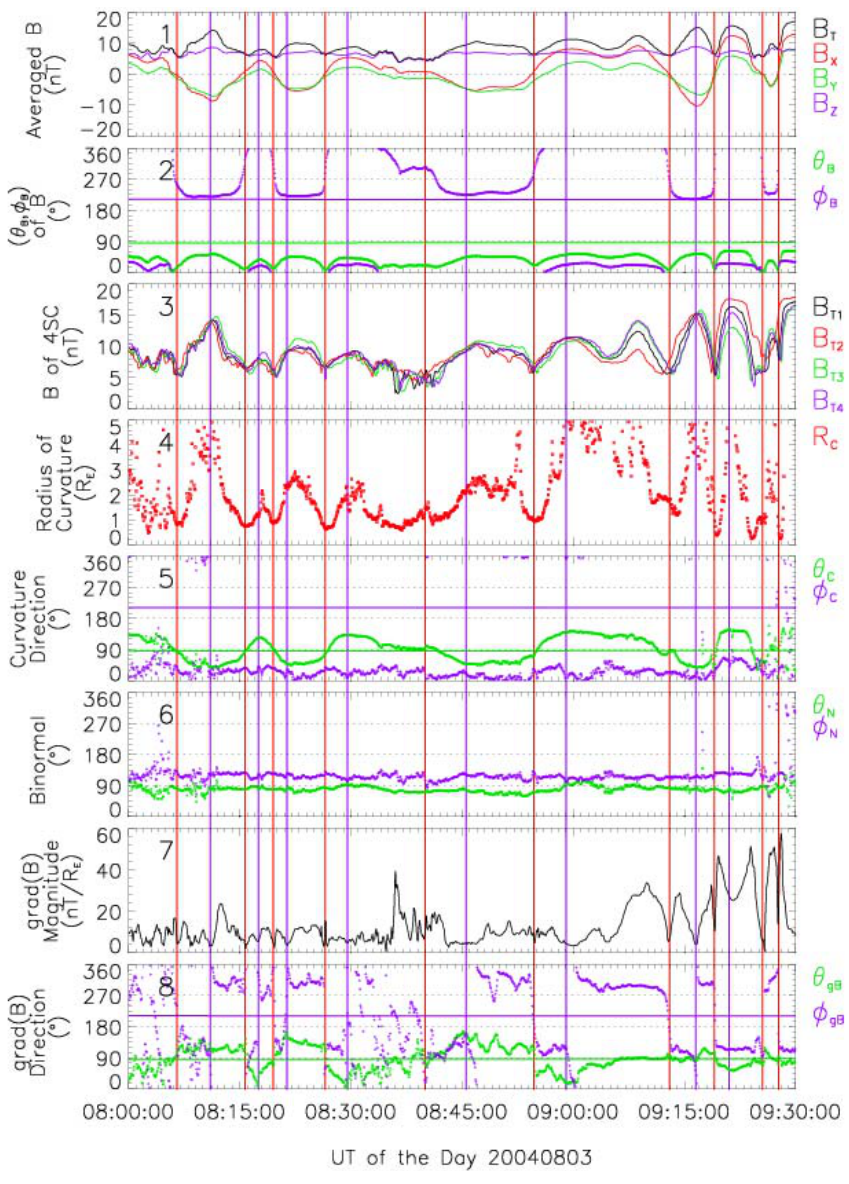
Fig. 7a. The geometric structure of the tilted current sheet during a series of Cluster crossings on 3 August 2004. The format of the figure is just same as that of Fig. 1a.